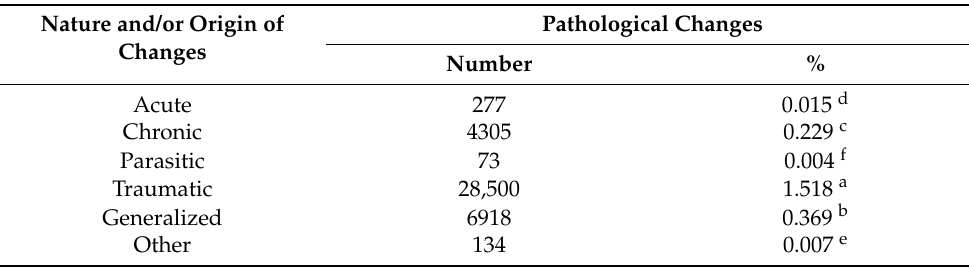
Table 2. The nature and/or origin of pathological changes found in rabbits (n = 1,876,929) after slaughter at the slaughterhouse.